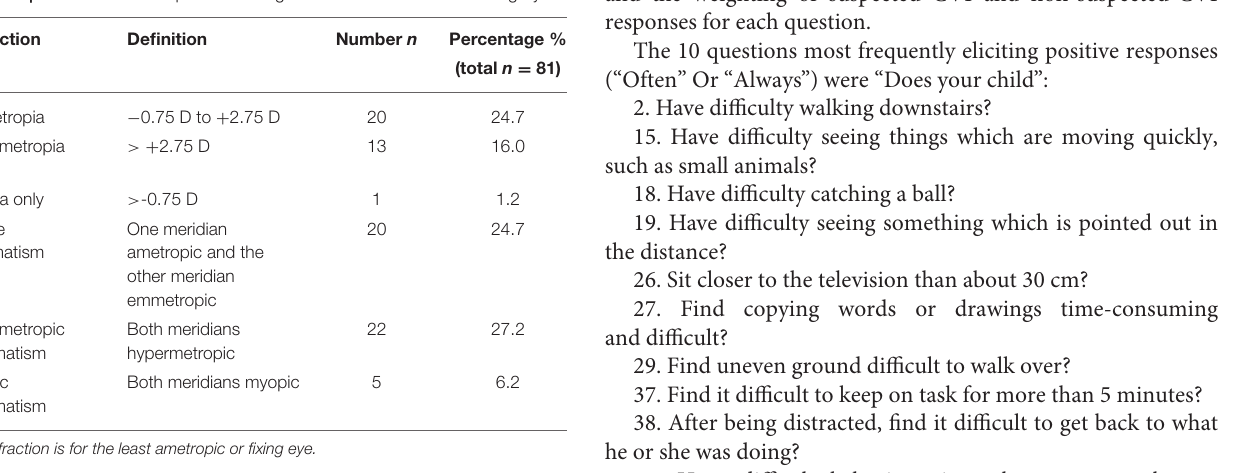
TABLE 1 | The number of responders falling into each refractive error